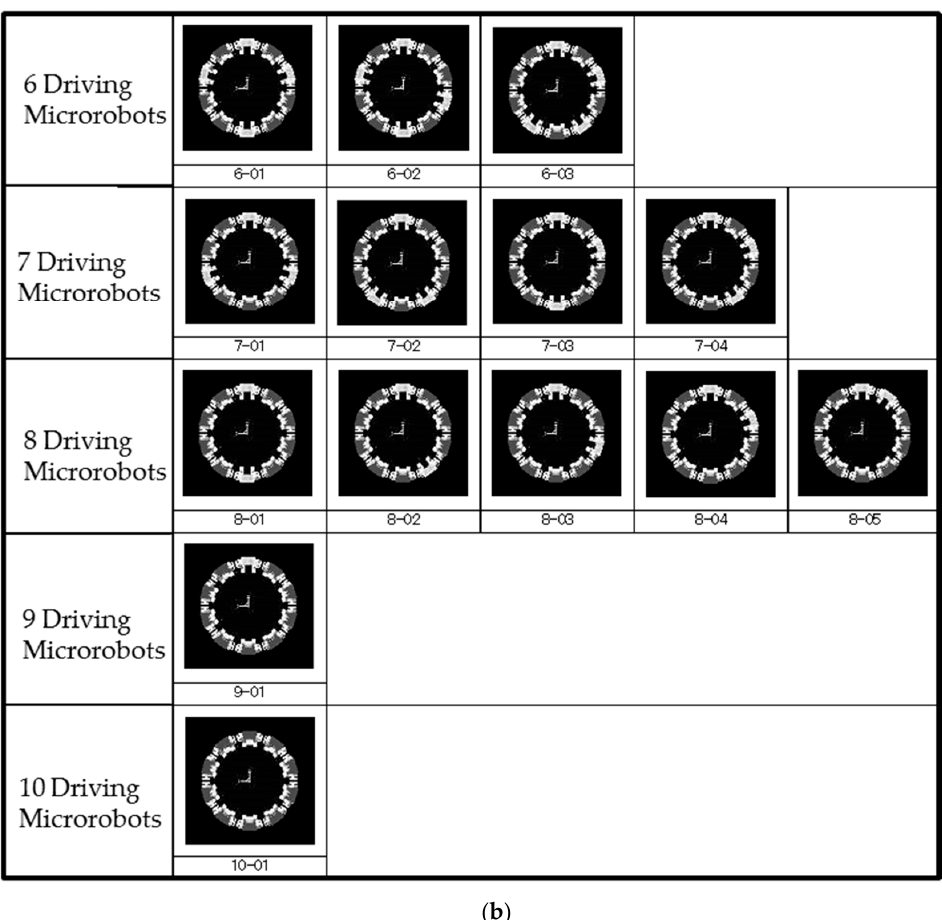
Figure 12. Layout patterns when surrounding the pipe with 10 microrobots. All combinations of driving microrobots and non-driving microrobots when surrounding the pipe with 10 microrobots are shown. Gray microrobots are the driving microrobots and white microrobots are the non-driving microrobots. ( a ) Layout patterns for 1 to 5 driving microrobots and ( b ) layout patterns for 6 to 10 driving microrobots.